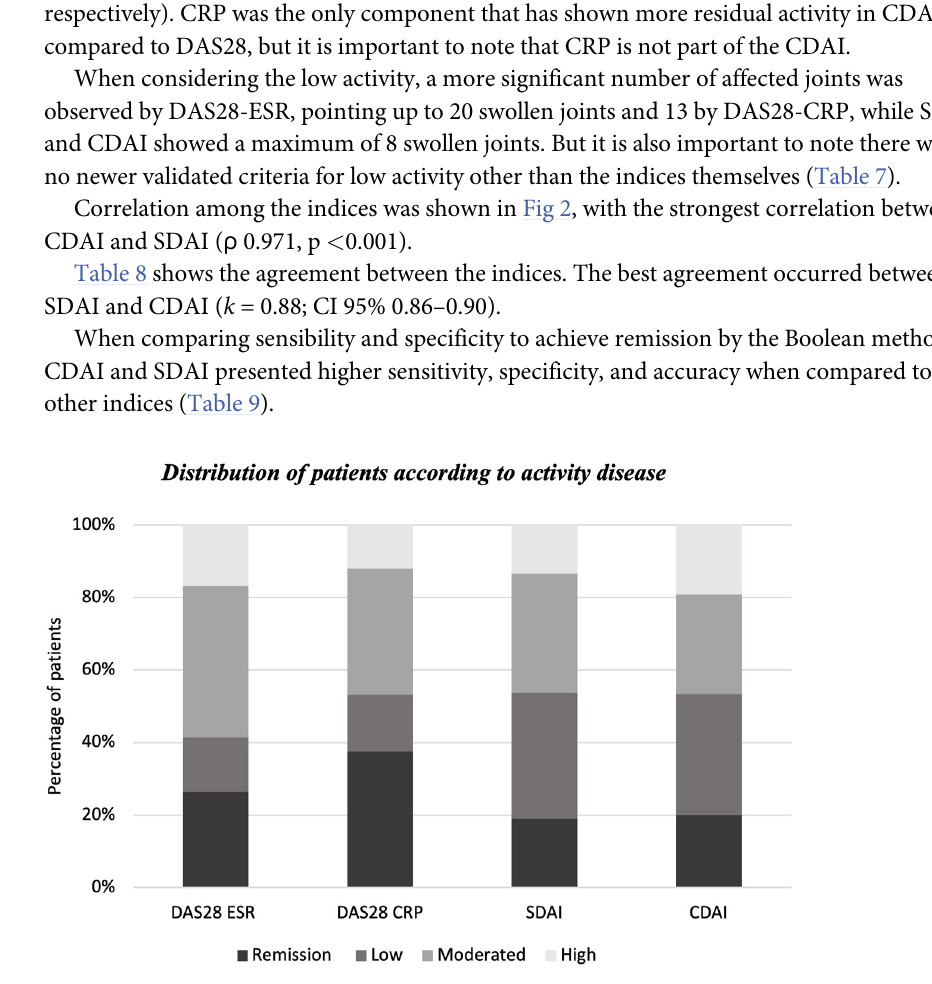
Fig 1. Distribution of patients according to disease activity. DAS28-CRP: Disease Activity Score 28- C reactive protein; DAS28-ESR: Disease Activity Score 28—erythrocyte sedimentation rate; SDAI: Simplified Activity Index; CDAI: Clinical Activity